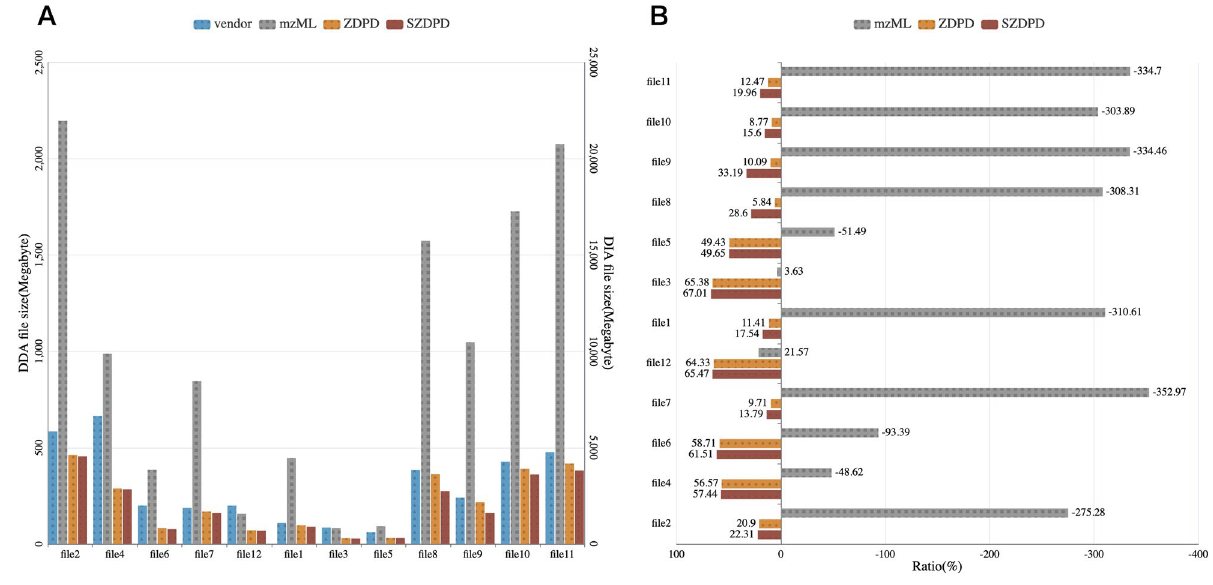
Figure 3. ( A ) File size of data stored with different format. For file 2, 4, 6, 7 and 12, the data acquisition mode is DDA, and the rest files are of SWATH/DIA mode. ( B ) Compression ratio of mzML, ZDPD and SZDPD.